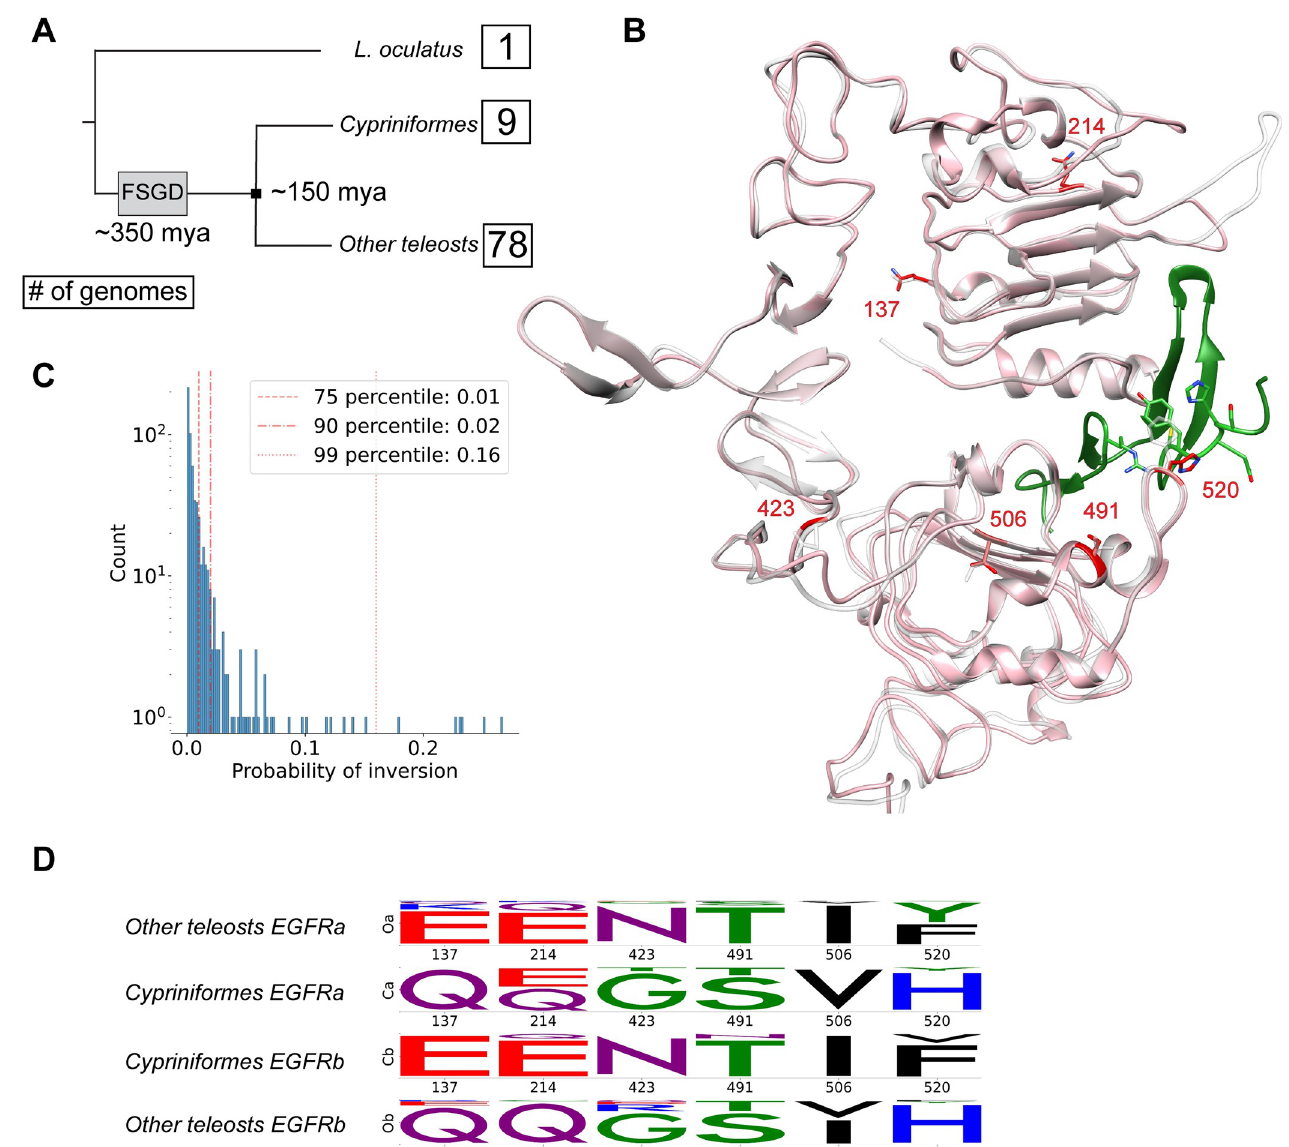
Fig 3. Inter-paralog inversions of amino acids in fish EGFR. (A) Schematic representation of the fish dataset phylogeny. The dates (mya: million years ago) indicate the time of the Fish Specific whole Genome Duplication (FSGD) and the separation of Cypriniformes fish to all other teleost fish. The number in the boxes represents how many genomes are in the dataset for that group. (B) 3D model superposition of S . anshuensis EGFRa (pink) and EGFRb (white), generated by homology using human EGFR as a template (1IVO) [48]. The inverted residues have been highlighted in red. The ligand EGF (green) was taken from the human model after superposing the receptors. (C) DIRphy score distribution. The inter-paralog inversion event probability score was calculated for each site in the MSA that has less than 60% gaps. The top 1% of sites were further characterized. (D) Logo representation of the four sub alignments (two species groups, two protein copies) in the inverted sites. The logo represents the normalized amino acid count per column and was obtained using the python package Logomaker [49].